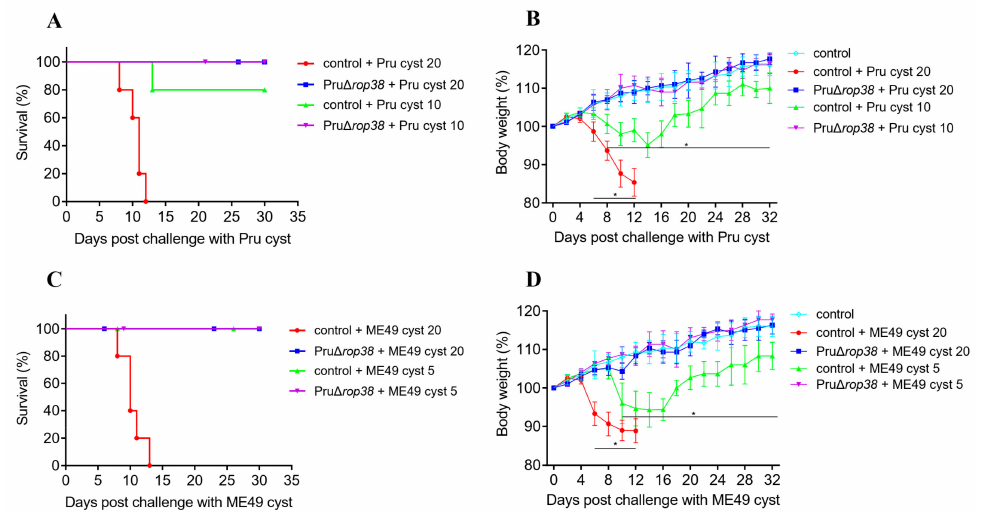
Figure 5. Protective efficacy against varied genotypes of cyst challenge. Survival rate and body weight gain of vaccinated and control mice re-challenged with ( A , B ) Pru (20 and 10) cysts and ( C , D ) ME49 (20 and 5) cysts ( n = 5; mice were injected orally; daily monitoring of mice for 30 days; presented as the mean of body weight ± SD; * p < 0.05; one-way ANOVA with Tukey).